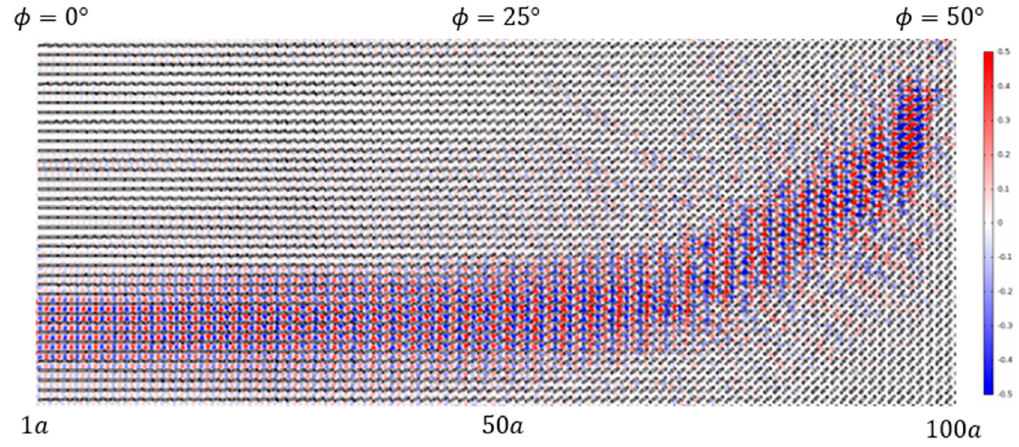
Figure 9. The displacement field simulation of the wave propagation in the phononic crystal composed of star-shaped honeycomb matrix and rectangular inclusions with gradually varied orientations in the x -direction. The orientation angle is φ = 0 ◦ at the left boundary, x = 0, and linearly increases to φ = 50 ◦ at the right boundary, x = 100 a . The orientation angles φ are linearly varied by φ ( x ) = ( x /100 a ) 50 ◦